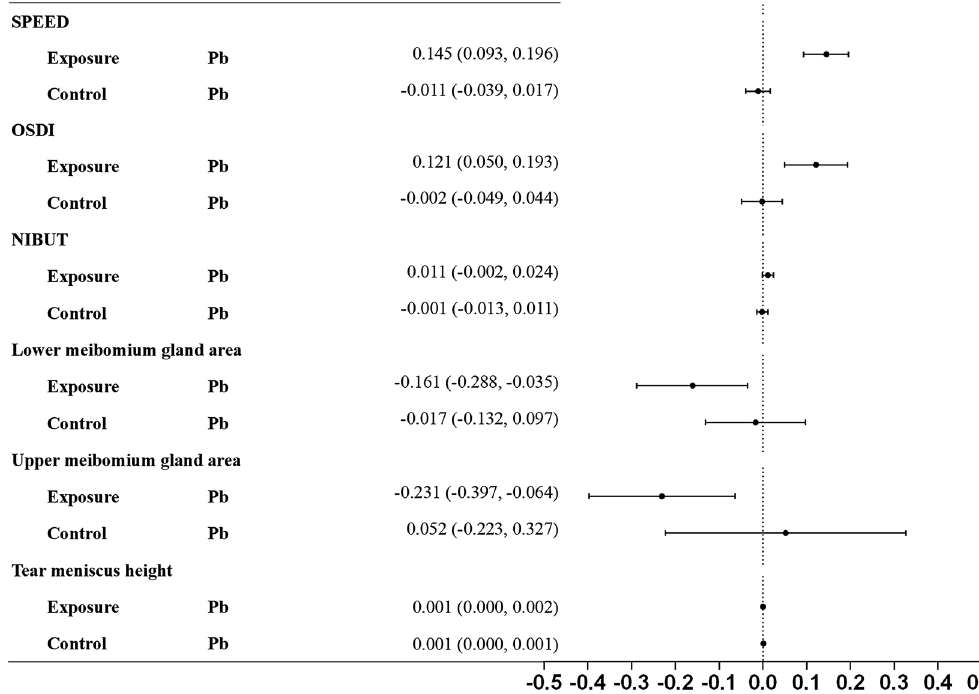
Figure 3. Associations between tear Pb and dry eye disease parameters in each exposure and control group.